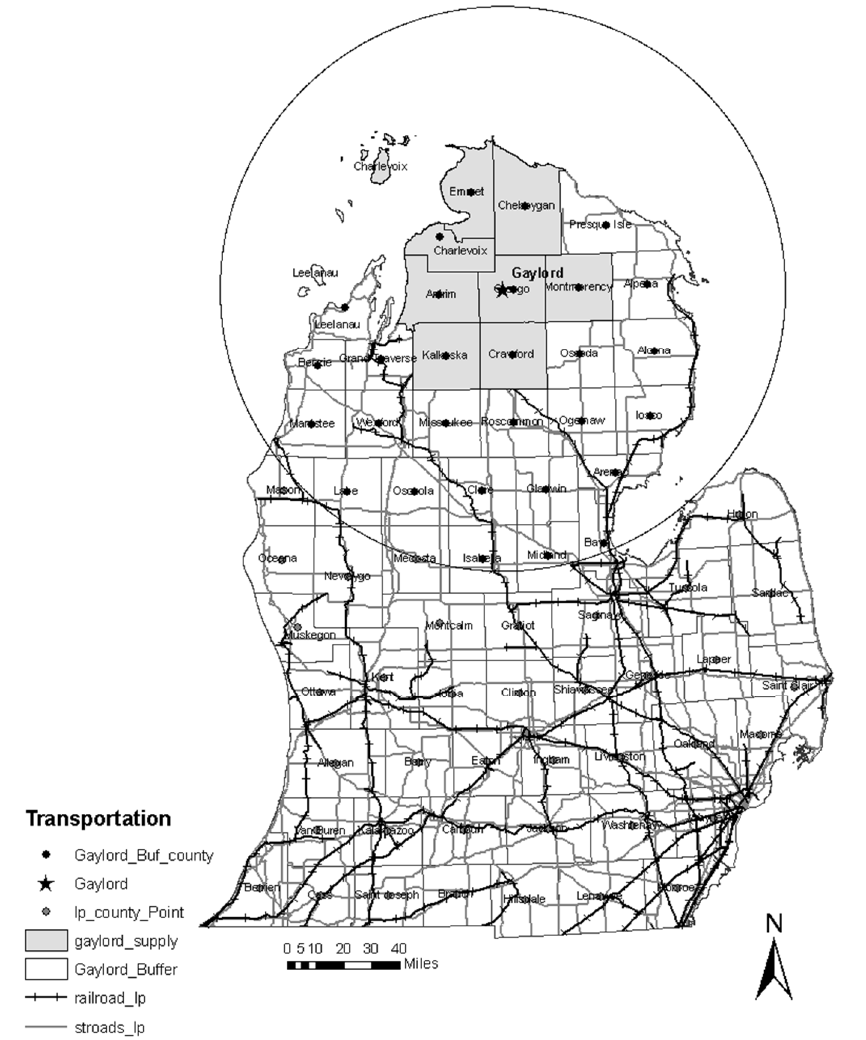
Figure 2. The map of the Gaylord city and the eight suppliers in